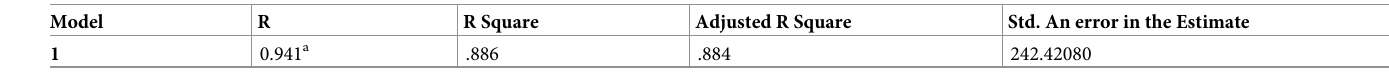
Table 16. Model summary. Model